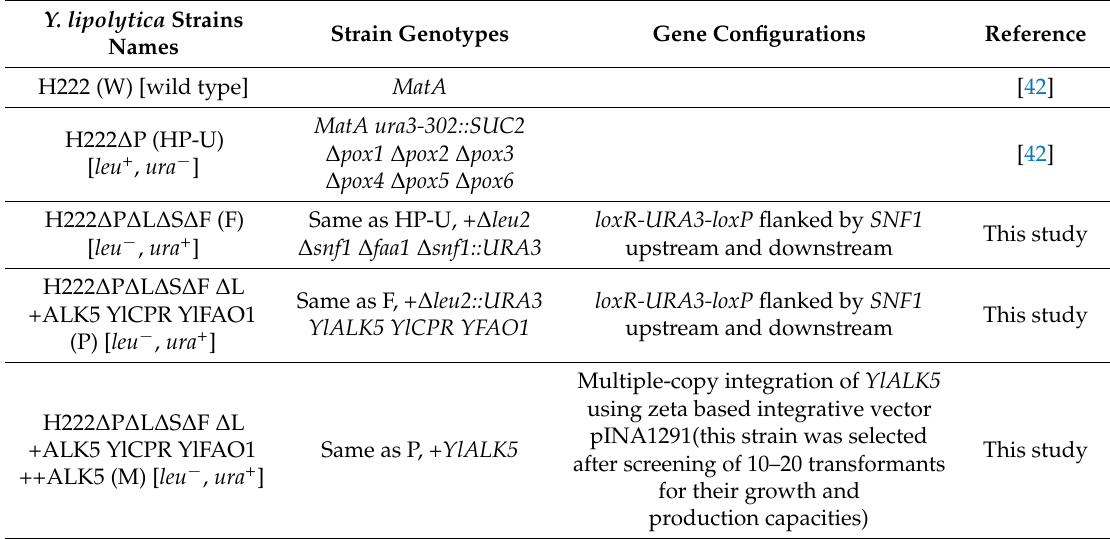
Table 1. Y. lipolytica strains used in this